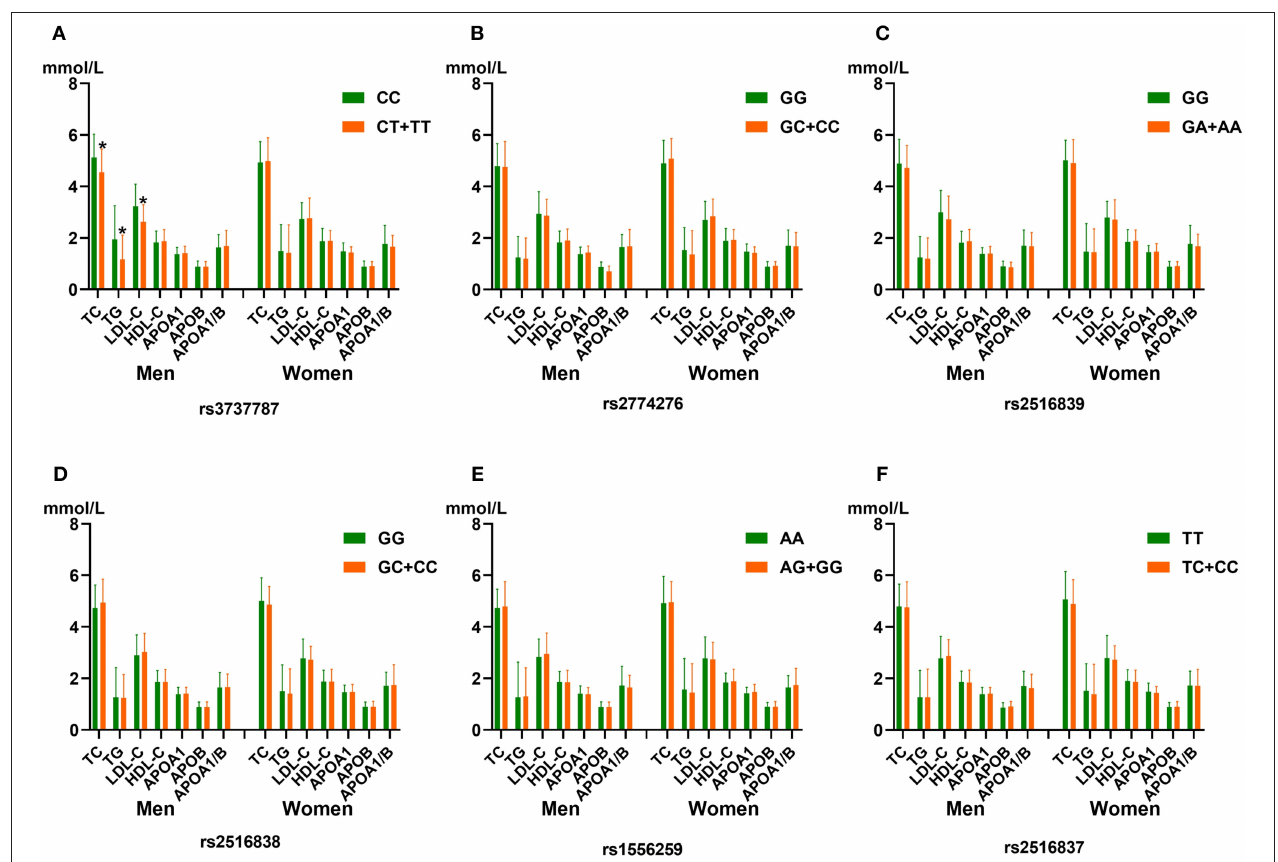
FIGURE 1 | The association between the genotypes of six upstream transcription factor 1 ( USF1 ) single-nucleotide polymorphisms (SNPs) and blood lipid levels in men and women from the control group. (A) rs3737787C > T, (B) rs2774276G > C, (C) rs2516839G > A, (D) rs2516838G > C, (E) rs1556259A > G, and (F) rs2516837T > C SNPs. HDL-C, high-density lipoprotein cholesterol; TC, total cholesterol; ApoA1, apolipoprotein A1; TG, triglyceride; ApoB, apolipoprotein B; LDL-C, low-density lipoprotein cholesterol; ApoA1/ApoB, the ratio of apolipoprotein A1 to apolipoprotein B. * p < 0.008 (after adjusting for six independent tests using the Bonferroni correction) was considered to be statistically